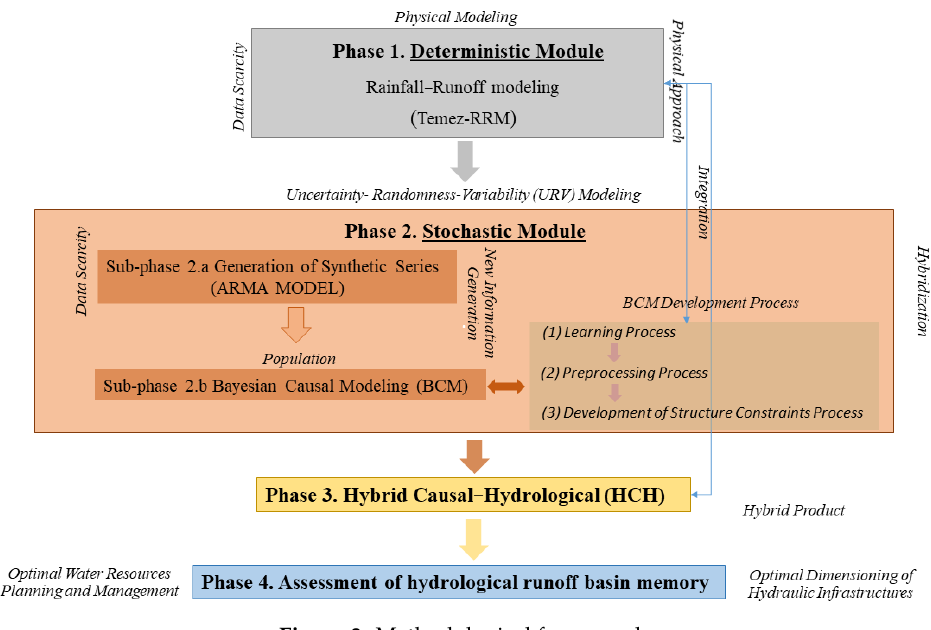
Figure 3. Methodological framework.